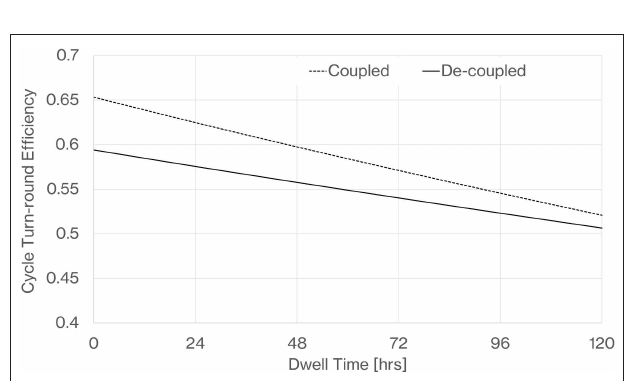
FIGURE 30 | Impact on turn-round efficiency from increasing dwell time.